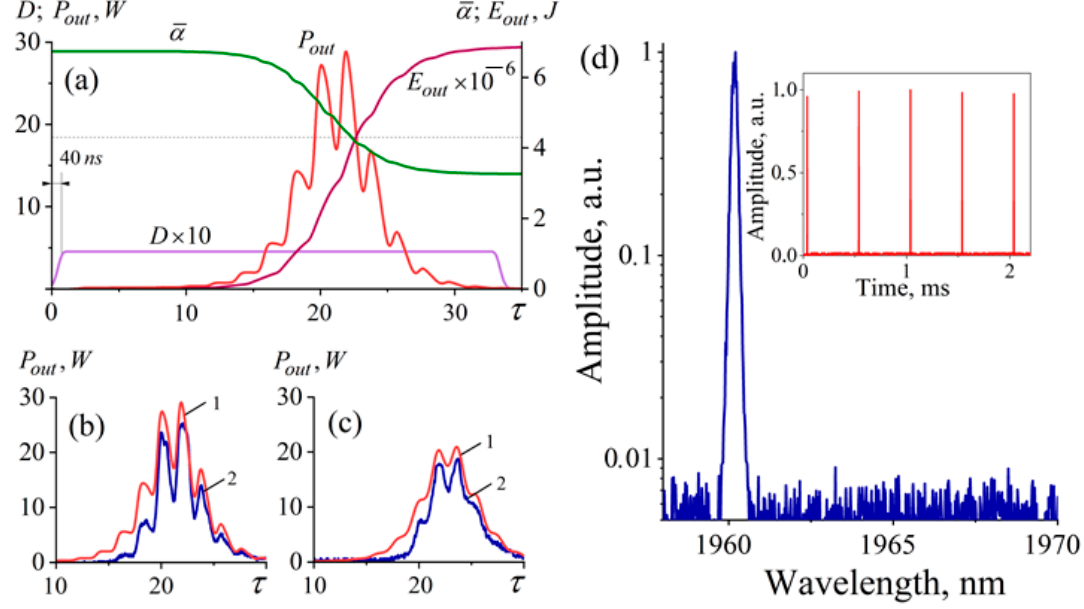
Figure 7. Time dependences of average gain ᾱ , output power Pout , pulse energy Eout and diffraction coefficient D ( a ); comparison with the experiment: Tq = 40 ns ( b ) and 80 ns ( c ); 1-simulation, 2- ex- periment. ( d ) Experimentally obtained emission spectrum at 1960 nm, on the inset a pulse train with a repetition rate of 2 kHz.